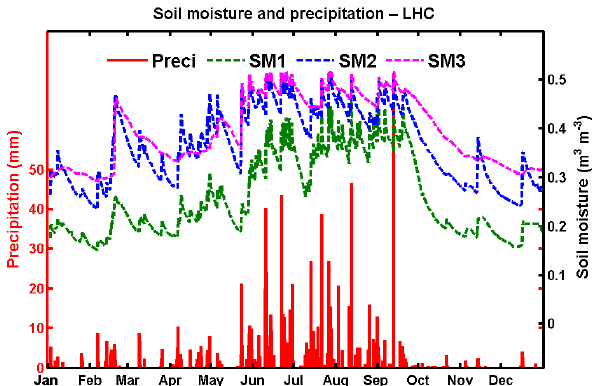
Figure 3. The weekly soil moisture (symbols, right axis) and hourly precipitation (red bars, left axis) observed at HAPEX during 1986. SM1, SM2 and SM3 represent the mean soil moisture in the 0– 20cm (green dot), 20–50cm (blue circle) and 50–160cm (magenta cross) layers,